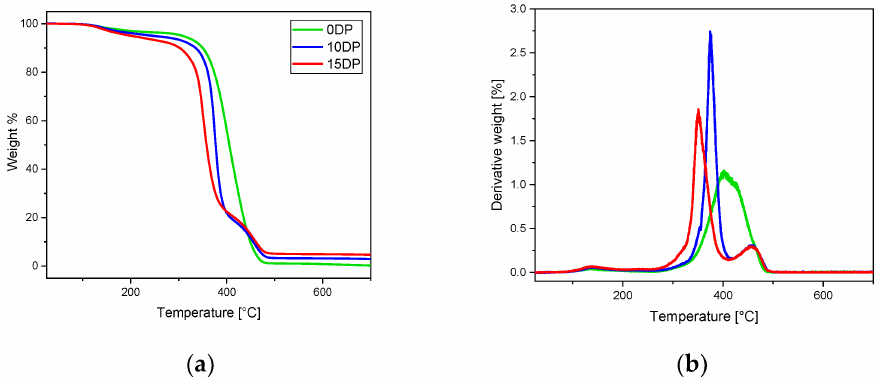
Figure 4. TGA thermal degradation curves of samples with 10 and 15 phr DP and reference sample without DP ( a ) and first derivative of thermal degradation ( b